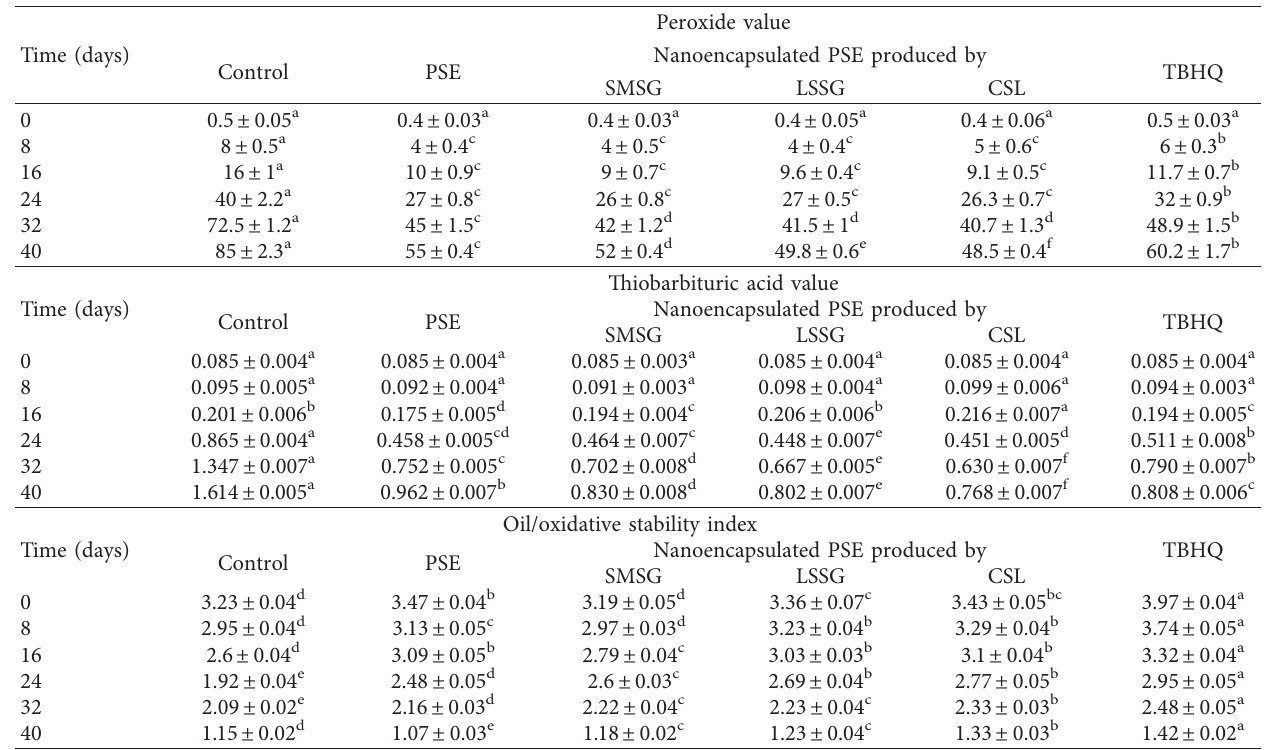
Table 3: Effect of adding free extract 2 and nanoencapsulated extract produced by SMSG, LSSG, and CSL at 1000ppm and TBHQ (100ppm) on peroxide value, thiobarbituric acid value, and oil/oxidative stability index of soybean oil under accelerated storage at 50 ° C for 40